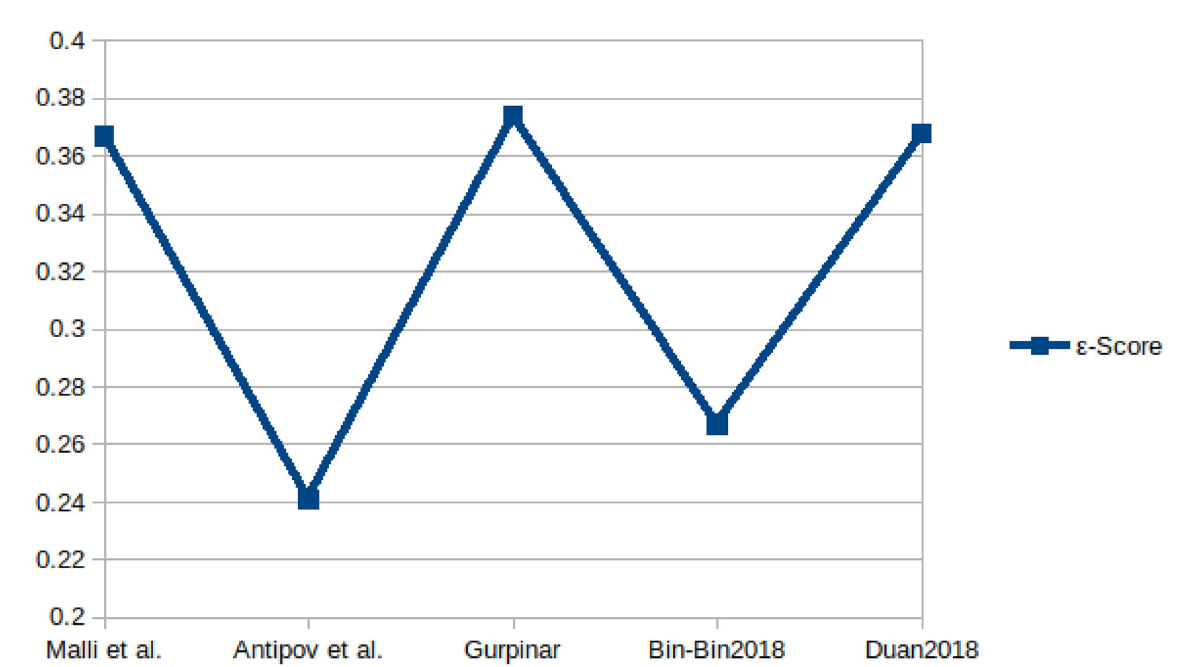
FIGURE7 Performance, in terms of ǫ -error, achieved by some authors on the Chalearn LAP 2016 dataset.